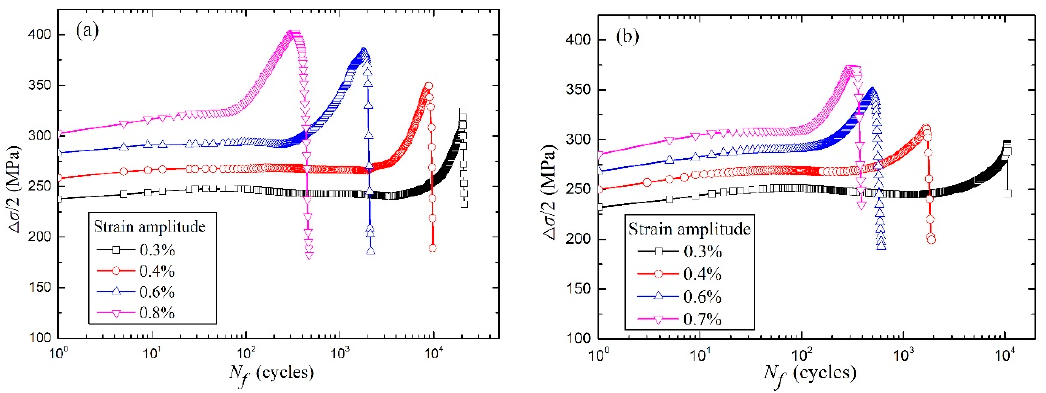
Figure 8. Cyclic stress response curve for ( a ) as-received sample; ( b ) aluminized sample.